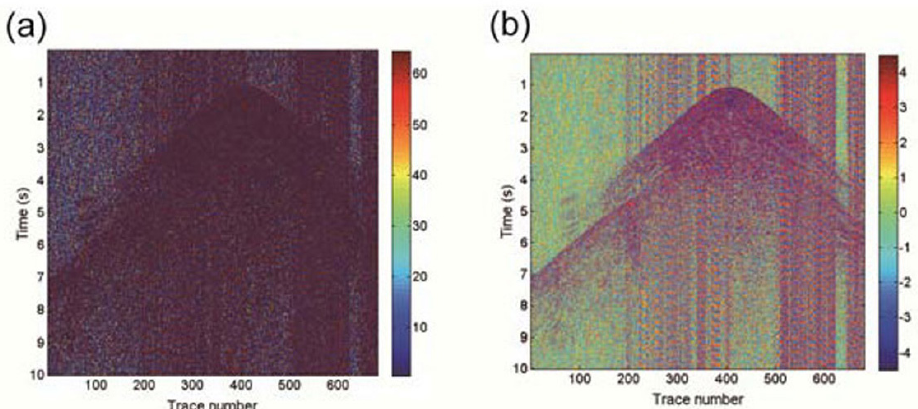
Fig. 6. OBS field data. (a) Original OBS data showing refraction and reflection events and harmonic noise. (b) Logarithmic transform of original OBS data.